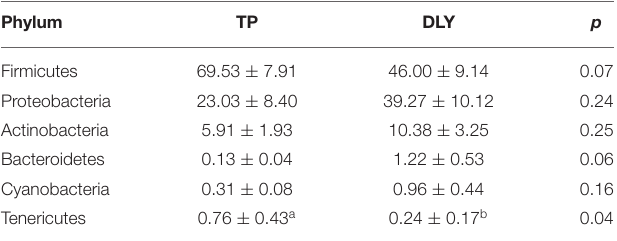
TABLE 6 | Analysis of the jejunal composition and differences at the phylum level of growing DLY and TP pigs.